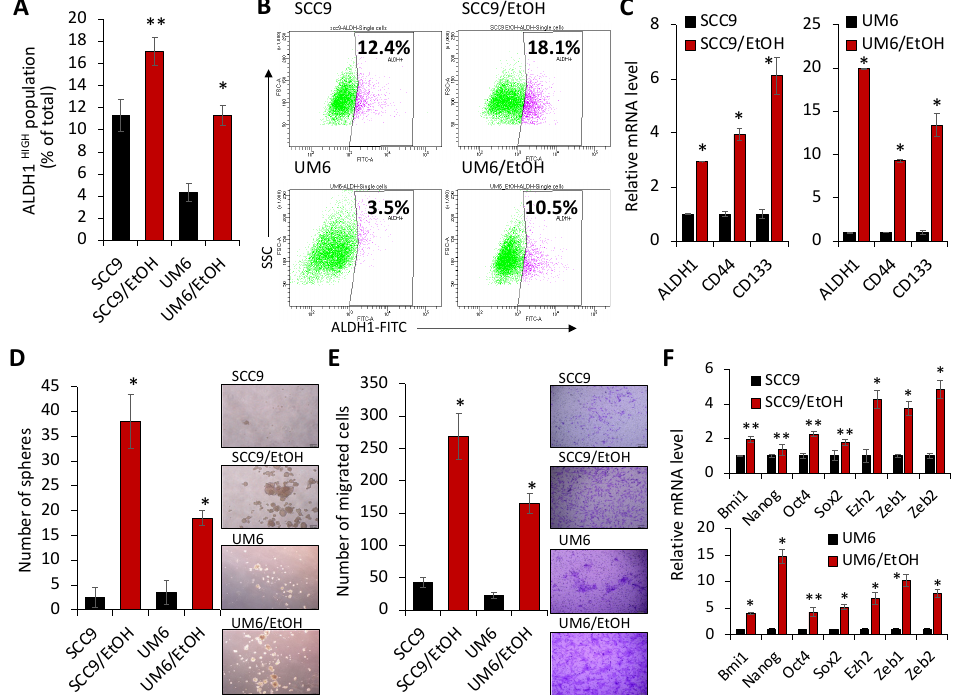
Figure 2. Chronic EtOH exposure enhances CSC population and property of OSCC. ( A ) Effect of chronic EtOH exposure on ALDH1 HIGH CSC population in OSCC was determined by Aldefluor flow cytometry-based assay. Data are means ± SD of three independent assays. * p < 0.001, ** p < 0.05. ( B ) Representative images of Aldefluor flow cytometry-based assay. The number shown in each panel reflects the percentage of ALDH1 HIGH cells in each cell type. ( C ) Effect of chronic EtOH exposure on CSC markers (ALDH1A, CD44, and CD133) in OSCC was determined by qPCR. * p < 0.001. ( D ) Effect of chronic EtOH exposure on self-renewal capacity in OSCC was measured by tumor sphere formation assay. Representative images of tumor spheres formed by the OSCC cells were shown on the right of bar graph. Data are means ± SD of triplicate experiment. * p < 0.001. ( E ) Effect of chronic EtOH exposure on migration ability in OSCC was determined by transwell migration